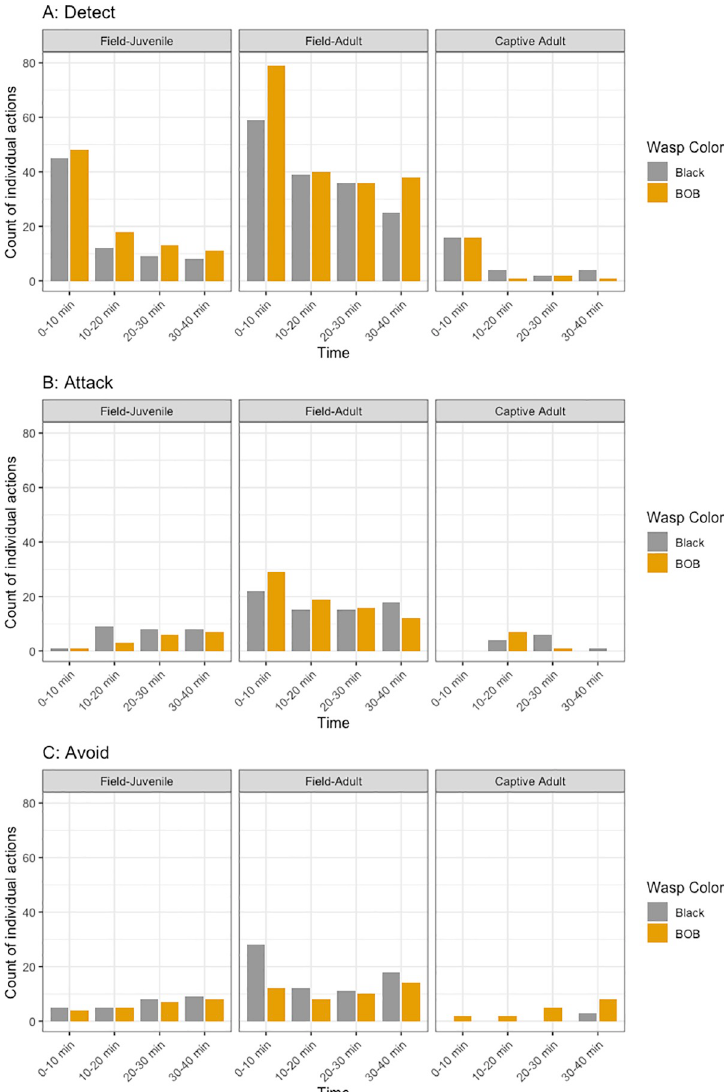
Fig 4. Frequency of individual behavioral responses experienced by L . jemineus when confronted with live wasps. Behaviors are: detection (A), attacking (B), avoiding (C) All bar plots are represented according to behavior per time, spider type and prey color (black and BOB). Time slots without bars indicate that none of the spiders performed that action during that time slot. The total individual actions is n = 954.